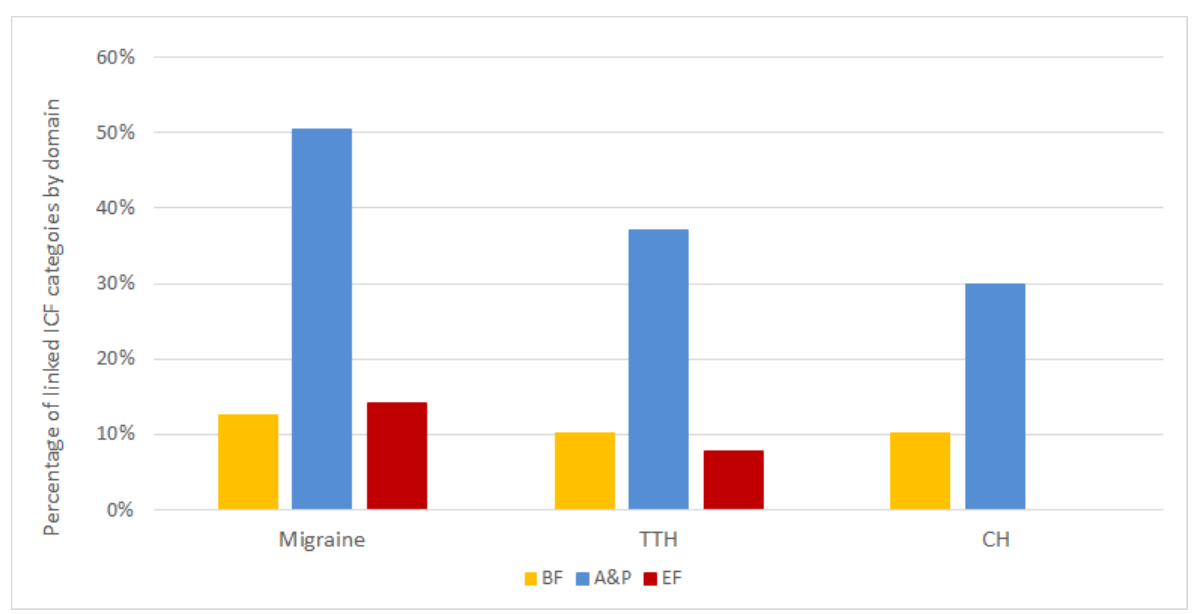
Figure 3. Overview of the percentage of linked categories by ICF domain and by each primary headache.